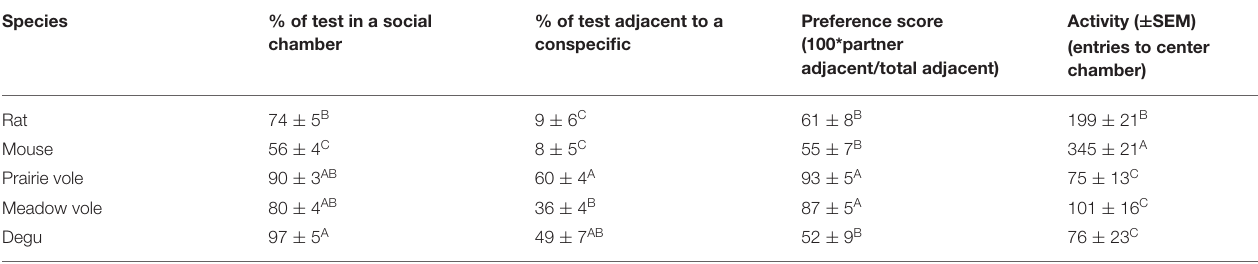
TABLE 2 | Species-specific measures of peer PPT behavior. Species % of test in a social